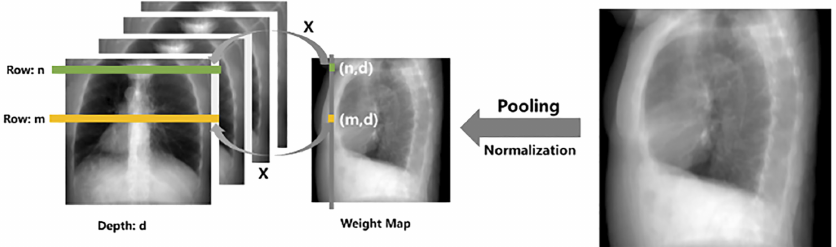
Figure 2. The details of